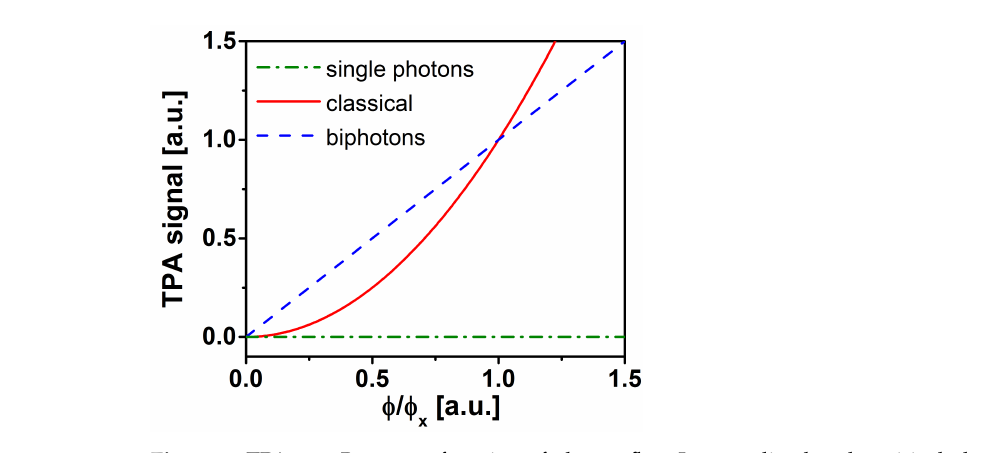
Figure 3. TPA rate R TPA as a function of photon flux Φ normalized to the critical photon flux Φ x for single photons, biphotons and classical